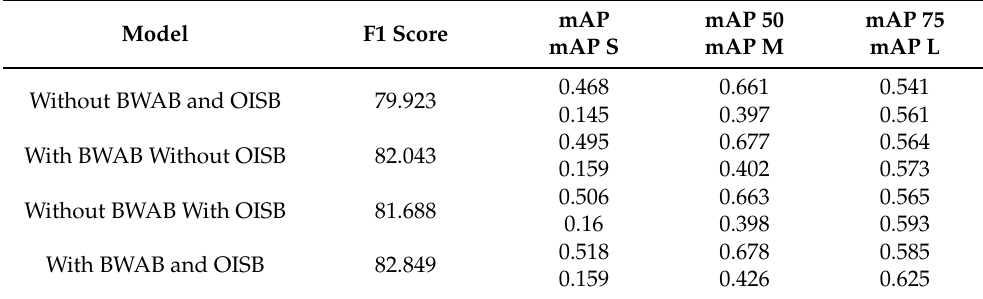
Figure 7. Sample images of dataset. Table 2. Performance of ARTD-Net1, S: small, M: medium, L: